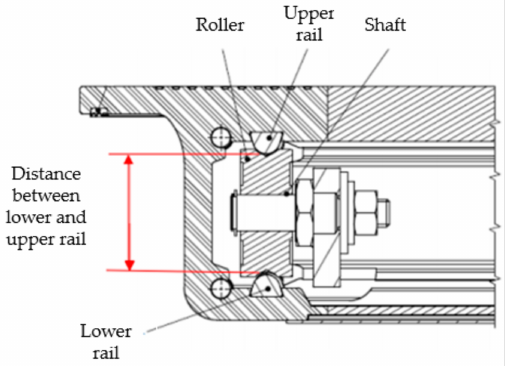
Figure 6. Details of side profile retractable step with rollers Fast Light Innovative Regional Train (FLIRT)